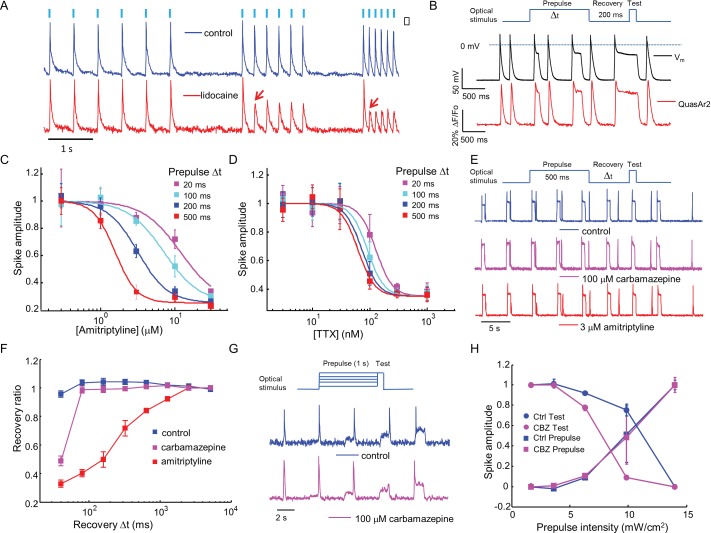
Mechanistic studies of NaV1.7 blockers.(A) Approximately 150 NaV1.7-OS HEK cells were stimulated with pulses of blue light (20 ms, 50 mW/cm2) at increasing frequencies (2 Hz, 4 Hz, 8 Hz) and their total QuasAr2 fluorescence was recorded with 635 nm excitation, 400 W/cm2. In control cells (blue), the fluorescence indicated spiking in response to each stimulus. After exposure to 200 μM lidocaine (red), cells showed activity-dependent block at 4 Hz and 8 Hz, but not at 2 Hz (red arrows). (B) Simultaneous current clamp and QuasAr2 fluorescence recordings from a NaV1.7-OS HEK cell cluster (4 cells) stimulated with prepulses of varying length (20, 100, 200 and 500 ms; 50 mW/cm2) followed by 200 ms recovery and a test pulse (30 ms, 50 mW/cm2). (C,D) Application of the protocol in (B) to dose-response curves for (C) amitriptyline or (D) TTX. Test pulse spike amplitude was normalized to its value in the presence of the lowest tested concentration of drug (n = 3–5 wells for amitriptyline per data-point; n = 4–6 wells for TTX per data-point; ~150 cells per well). (E) Optical assay of NaV1.7 recovery from fast inactivation. A 500 ms prepulse (50 mW/cm2) populated the fast inactivated state and allowed drug binding. A variable recovery period (40 ms to 5120 ms) was followed by a 20 ms test pulse (50 mW/cm2). Traces show fluorescence of QuasAr2 for control cells and after addition of either 100 μM carbamazepine or 3 μM amitriptyline. (F) Ratio of spike amplitude in test pulse to spike amplitude at the longest recovery time (5120 ms), as a function of recovery time. Carbamazepine modestly slowed recovery and amitriptyline dramatically slowed recovery (n = 9–11 wells per curve, ~150 cells per well). (G) Optical protocol to measure voltage-dependent NaV1.7 activation and inactivation. Cells were stimulated with 1000 ms prepulse with increasing intensity (1.7, 3.6, 6.3, 9.8, 14 mW/cm2), immediately followed by a test pulse (150 ms, 14 mW/cm2). Traces show representative fluorescence recordings of control and 100 μM carbamazepine. (H) Effect of carbamazepine on activation and inactivation curves. Spike amplitudes were normalized to the maximum spike amplitude in the trace and were then plotted against prepulse intensity (n = 3 wells per curve). Carbamazepine left-shifted the inactivation curve, decreasing the optically measured overlap between activation and inactivation.